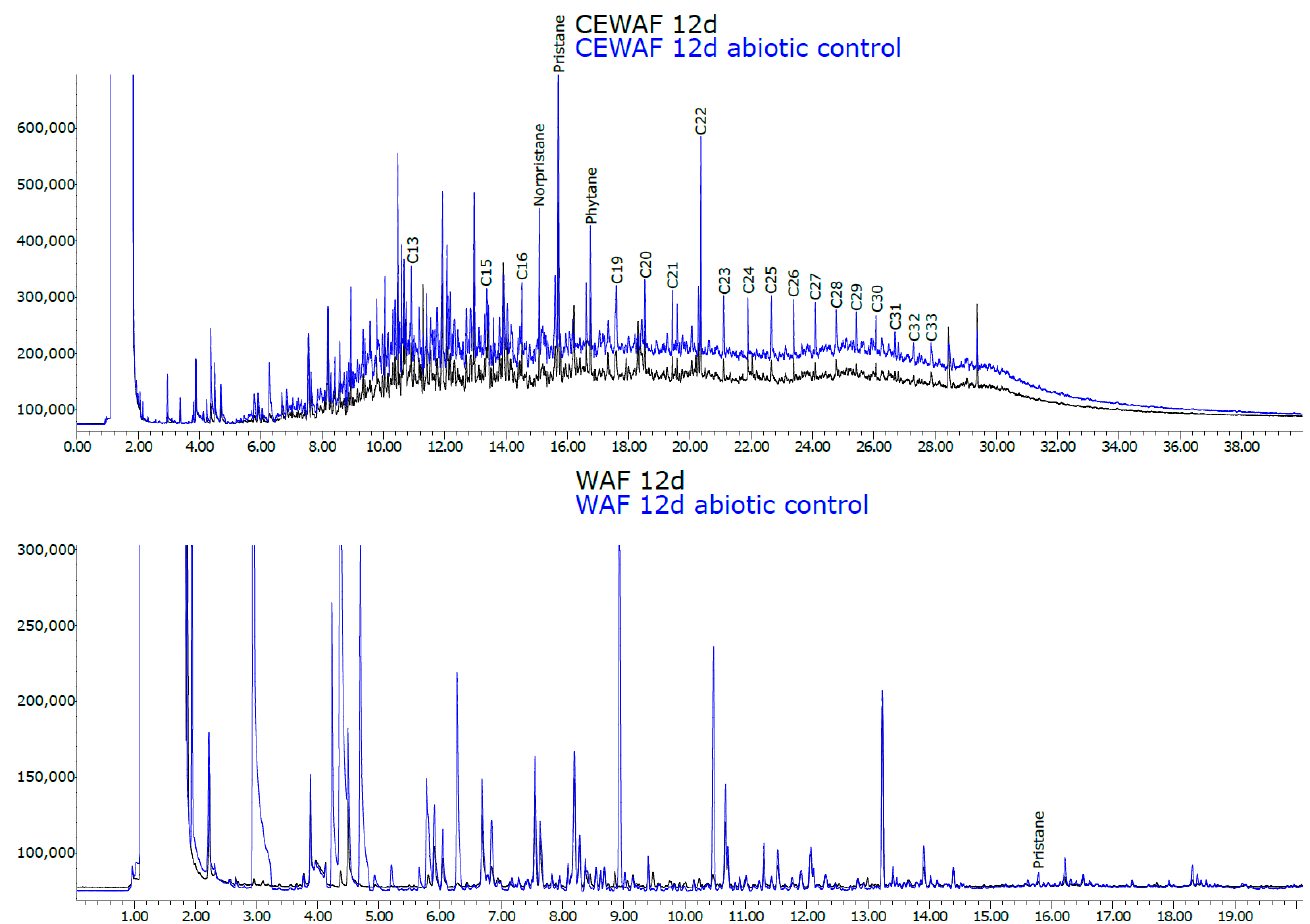
Figure 3. Comparison of gas chromatograms from the control experiment for WAF (without dispersant, dilution 1:1) and CE-WAF (with dispersant, dilution 1:50) at the end of the 12 d experiment. Black color indicates normal 12 d WAF or CE-WAF sample, and blue color indicates abiotic control.